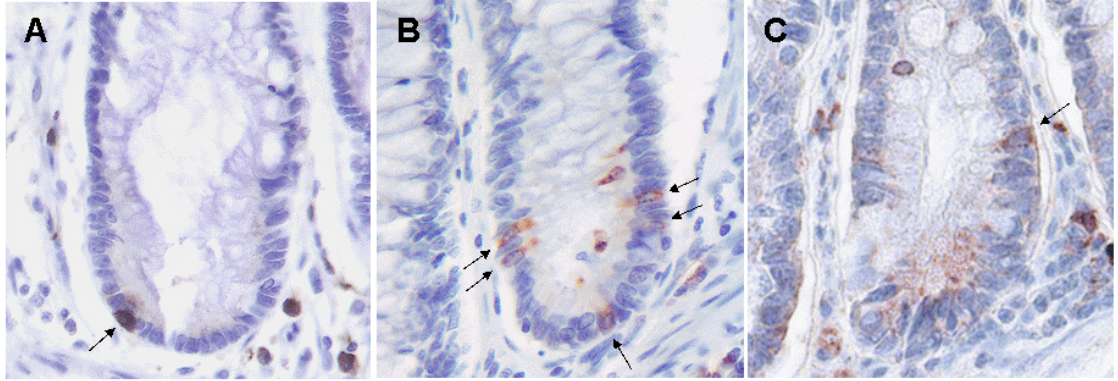
FIGURE 1. Lgr5 immunostaining is restricted to cells at the base of crypts (arrows) in normal human colonic and small intestinal mucosa. Lgr5 antibody to the second cytoplasmic domain in (A) colon (40 × ) and (C) small intestine (40 × ), and Lgr5 antibody to the N- terminal extracellular domain in (B) colon (40 ×